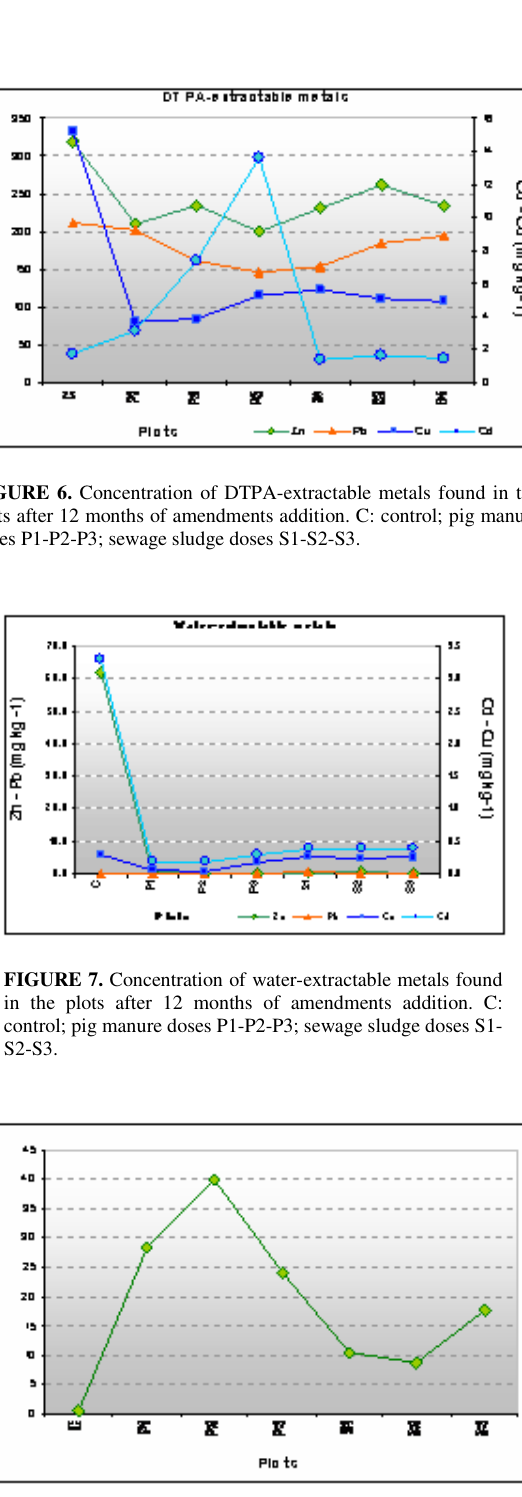
FIGURE 8. Percentages of plant cover found in the plots after 12 months of amendments addition. C: control; pig manure doses P1-P2- P3; sewage sludge doses